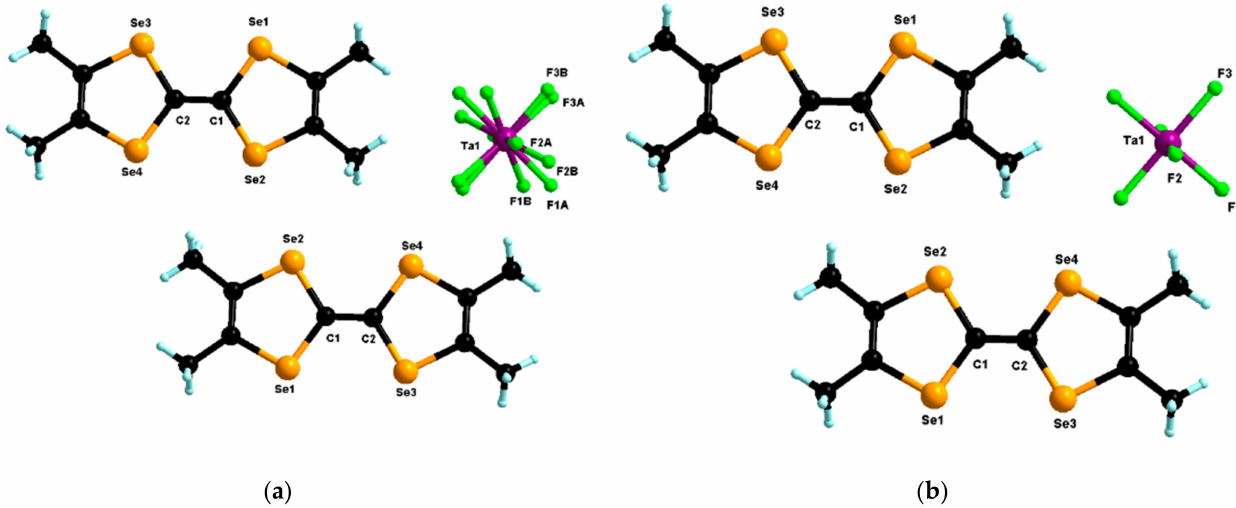
Figure 1. Molecular structures of (TMTSF) 2 TaF 6 at 293 K ( a ) and 100 K ( b ). For the structure at 293 K, the three independent fluorine atoms of the anion were disordered over two positions with partial refined occupancy factors of